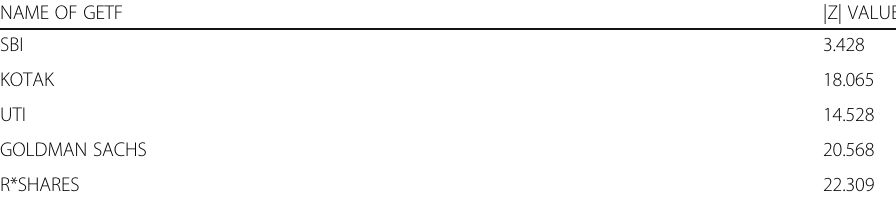
Table 2 Runs test values for daily returns of